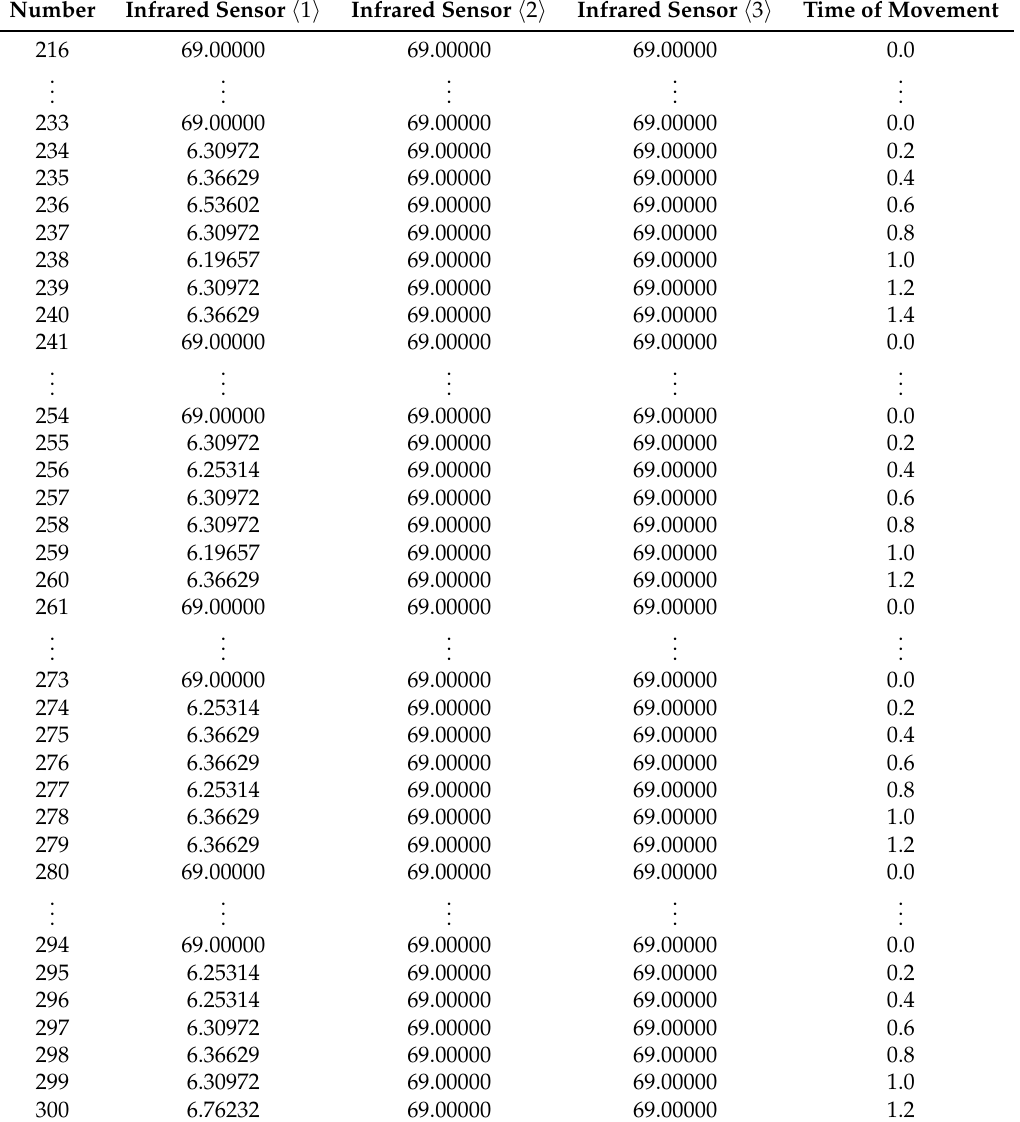
Table 3. Sample of the collected driver A’s frame data used in the experiment. (scenario III, the straight section ( 5 (cid:13) ), Infrared sensor (cid:104) 1 (cid:105) :